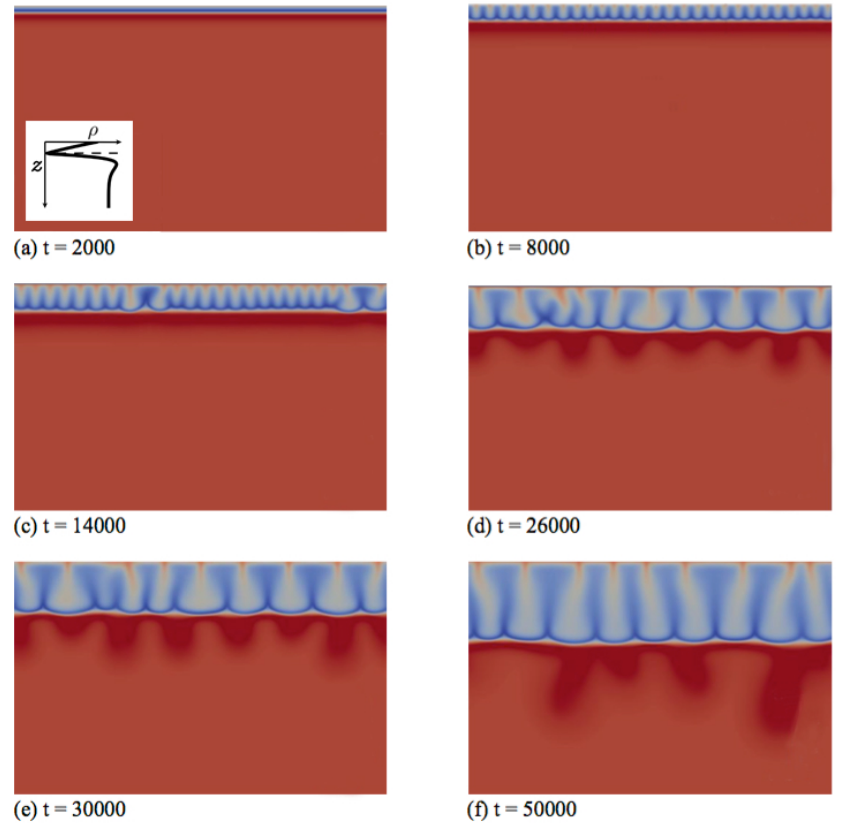
Figure 6. Density fields at different times ( a – f ) illustrating the fingering dynamics in Zone IV for the density profile enclosed in the first panel ( δ B = 0.3, δ C = 1 and R B = 2). The density scale varies between 0.84 (dark blue) and 2.2